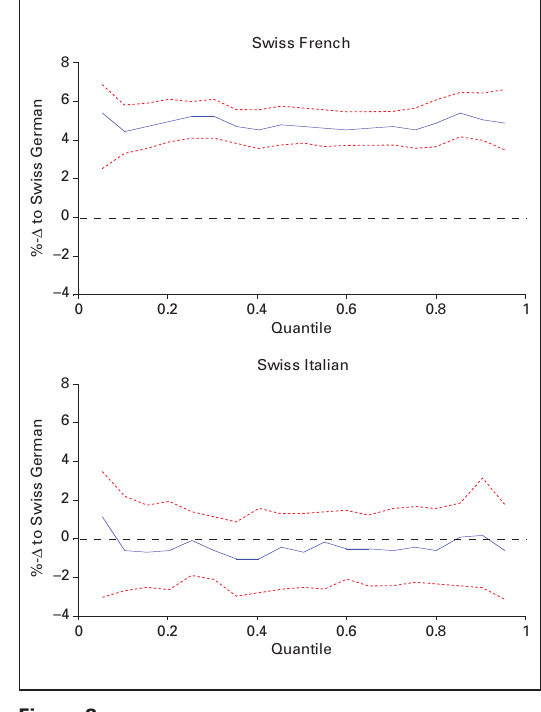
A significant impact of individual age can be found primarily for all cholesterol levels for the age group of the 21 year